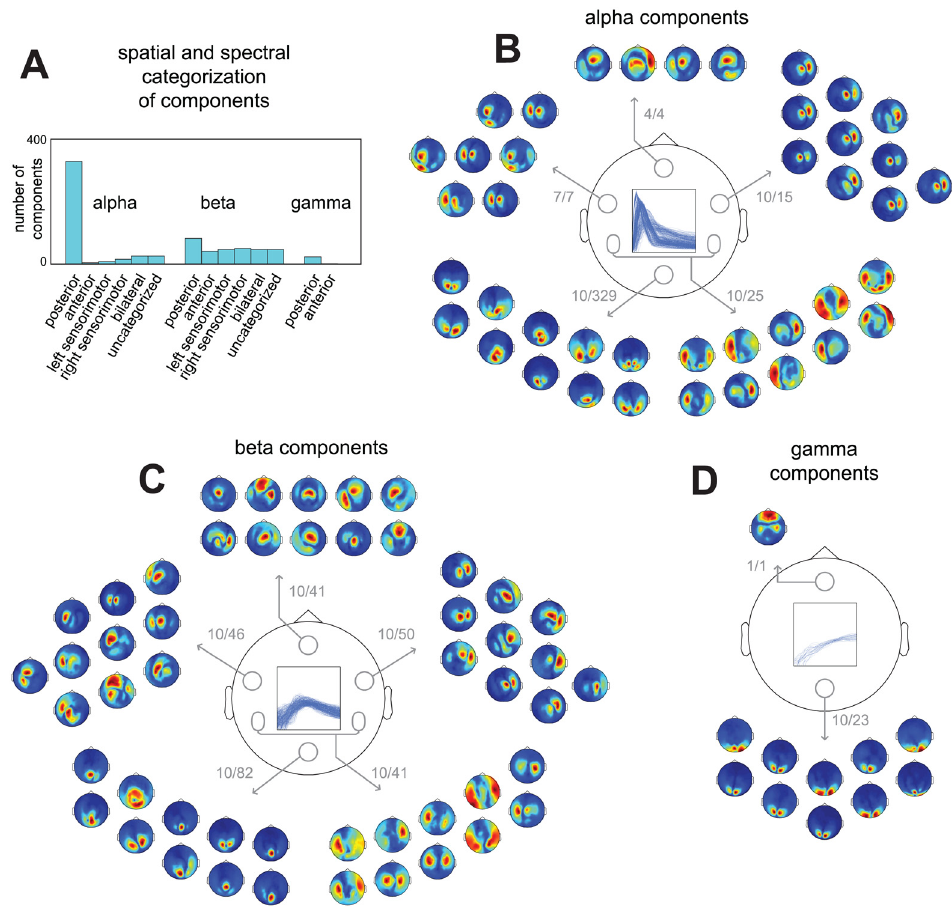
Fig 6. Spatial and spectral diversity of sources described by 783 components extracted from MEG recordings during a cued tactile detection task. 783 components were extracted using the analysis pipeline present in Fig 3 from MEG recordings of 11 subjects in 22 sessions performing a cued tactile detection task, split into 3 trial periods, resulting in 66 datasets. Per dataset we extracted on average 12.0 (SD = 2.0) components, explaining on average 50.7% (SD = 6.5%) of the variance in its CSDs. Based on their frequency profiles we classified 423 components as alpha, 332 as beta, and 28 as gamma components. To visualize their spatial diversity we categorized components based on the distribution of their spatial amplitude maps in 6 categories, describing posterior, anterior, left sensorimotor, right sensorimotor, and bilateral components, and a rest category (see Materials and Methods). A , summary of spatial and spectral categorization. B , 10 exemplars of alpha components from each spatial category (see Materials and Methods). Numbers indicate the selected and the total number of components in each category. C , same as in B but for beta components. D , same as in B but for gamma components. From A-D we observe that the extracted components consisted of (1) posterior alpha, beta, and gamma components, (2) sensorimotor alpha and beta components, and (3) some deep (or distributed superficial) alpha but mostly beta components (anterior and bilateral